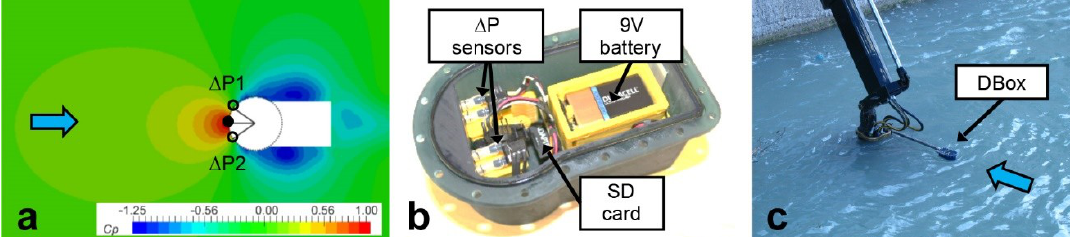
Figure 6. ( a ) Computational fluid dynamics (CFD) simulation results showing the spatial distribution of the pressure coefficient, C p , for a freestream velocity of 50 cm/s. The solid circle corresponds to the stagnation point, and the open circles the two differential ports ∆ P 1 and ∆ P 2 . ( b ) Photograph of the device including the two differential pressure sensors, as well as the 9V power supply and SD data storage card. ( c ) Image of the DBox in the field at the HPP Kirchbichl, mounted on the large debris removal arm. Water flow direction shown as a blue arrow.